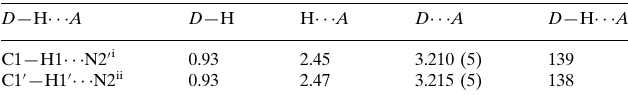
Hydrogen-bond geometry (A˚ , (cid:1)